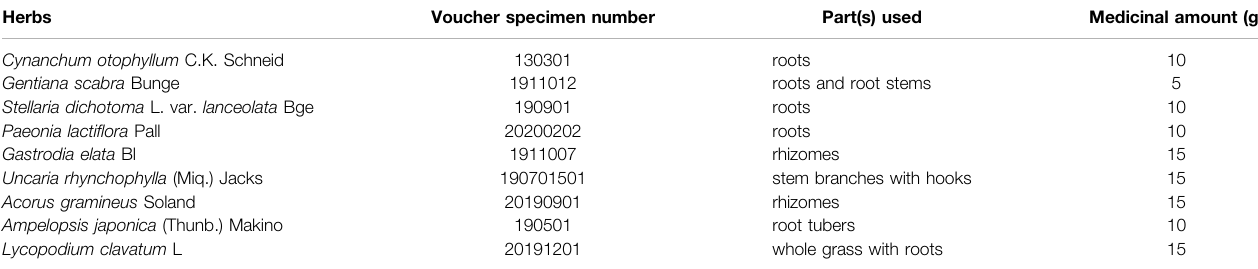
TABLE 1 | The composition and the relevant information on the components of QLZDD.